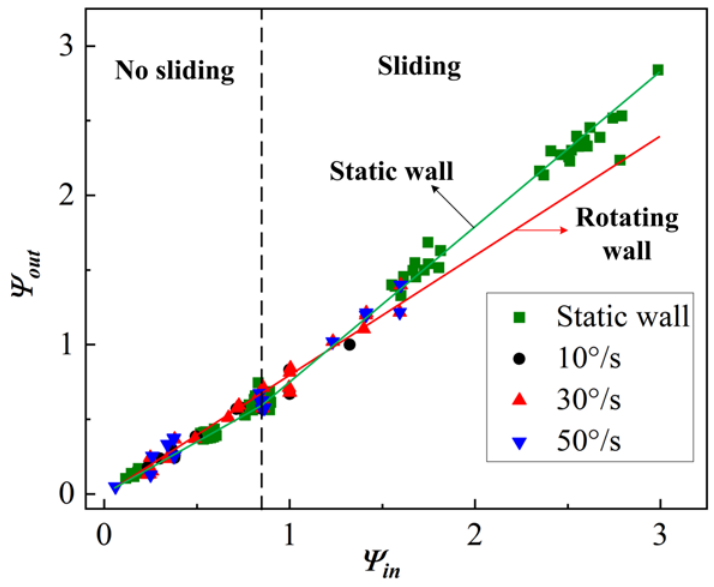
Figure 5. Processing results based on tangential compliance theory.